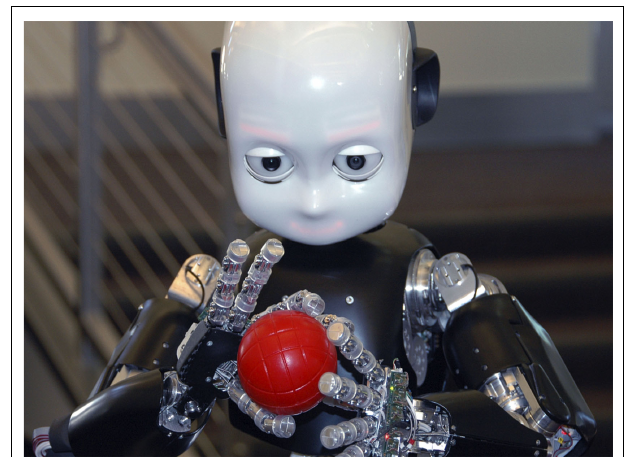
FIGURE 10 | The iCub humanoid robot: an open-systems platform for research in cognitive development .